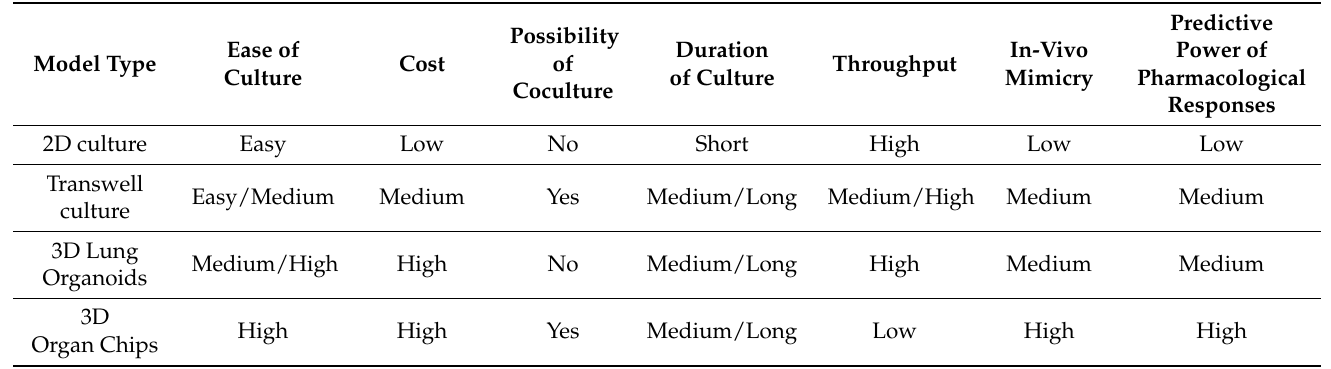
Table 2. Comparison of the available in vitro lung models to study SARS-CoV-2